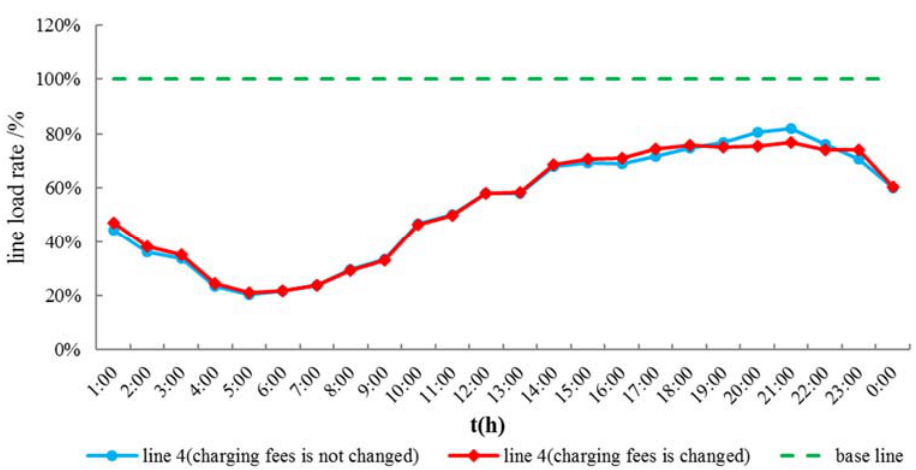
Figure 6. Line load rate of line 4 before and after adjustment for charging fees.